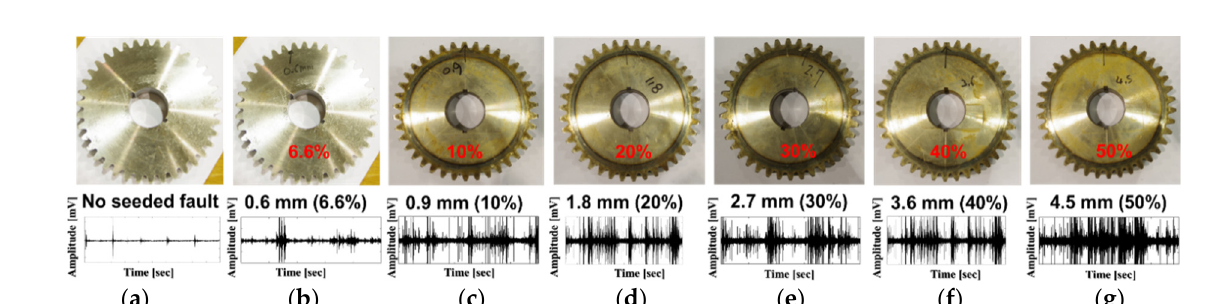
Figure 8. The observed defect types of the multi-degree tooth faults on the gear wheel and examples of vibration signals at